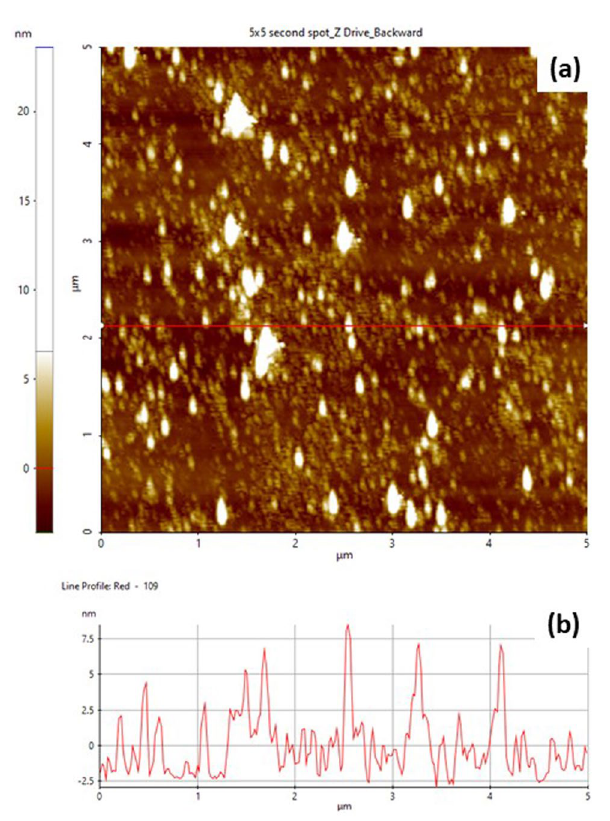
Figure 3. (a) AFM topography image of Nb 2 C MXene and (b) the corresponding lateral height